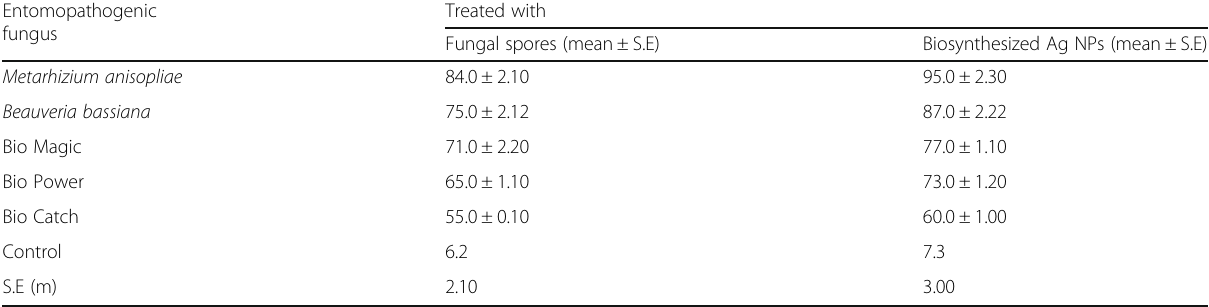
Table 2 Mortality percent of entomopathogenic fungi on the larvae of Rhynchophorus ferrugineus using spore suspension and biosynthesized silver nano-particles Entomopathogenic